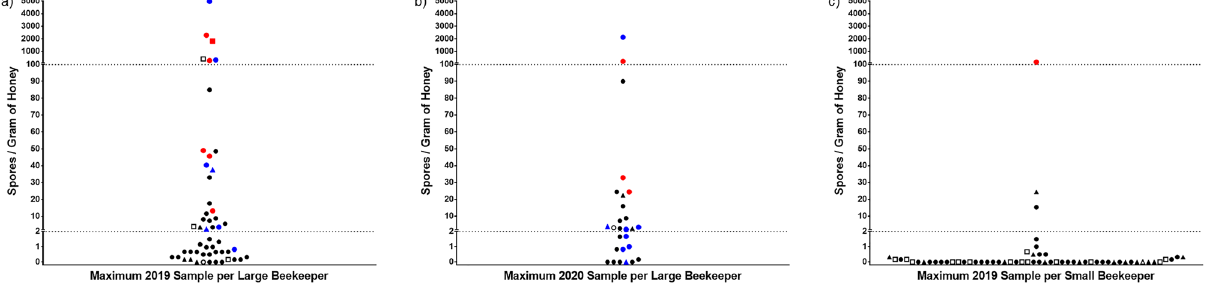
Figure 2. Maximum spore concentrations of Paenibacillus larvae in pooled, extracted honey relative to future and historical AFB occurrence. ( a ) Maximum 2019 spore concentrations of large-scale (L) beekeepers; ( b ) maximum 2020 spore concentrations of L beekeepers; ( c ) maximum 2019 spore concentrations of small-scale (S) beekeepers. Samples highlighted in red indicate occurrence of AFB in the subsequent year from the year the sample was collected in. Samples highlighted in blue indicate historical occurrence of AFB within the preceding four years. Samples with open centers are those missing information on future and/or historical AFB occurrence. Dotted lines represent cut-off values delimiting categories of future AFB risk where two spores per gram of honey differentiates low from moderate risk and 100 spores per gram of honey differentiates moderate from high risk. Circles represent current antibiotic use or cessation of antibiotic use after 2017. Triangles represent those beekeepers who have never used antibiotics or cessation during or prior to 2017. Squares represent missing information on antibiotic